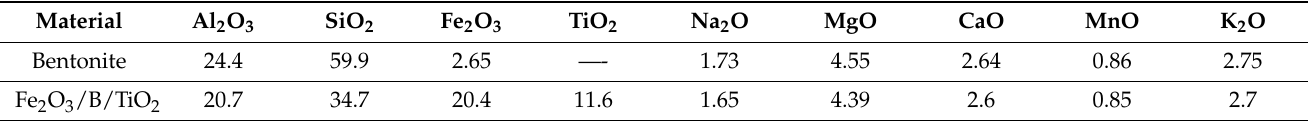
Figure 4. Comparison of RR198 degradation by UV light ( a ), Comparison of RR198 degradation by Visible light ( b ), Effects of RR198 concentration ( c ), Effects of Fe 2 O 3 /B/TiO 2 dosage ( d ), Effects of solution pH ( e ), Determination of the pH pzc ( f ). 3.4. Stability and Reusability of the Photocatalyst To keep the conditions optimal, the reusability of the Fe 2 O 3 /B/TiO 2 photocatalyst was tested for the degradation of RR198. From Figure 5a, no significant decrease was observed in the removal efficiency after the photocatalyst was used four times. In the present work conducted for dye removal, the photocatalyst cited above was isolated and used in the